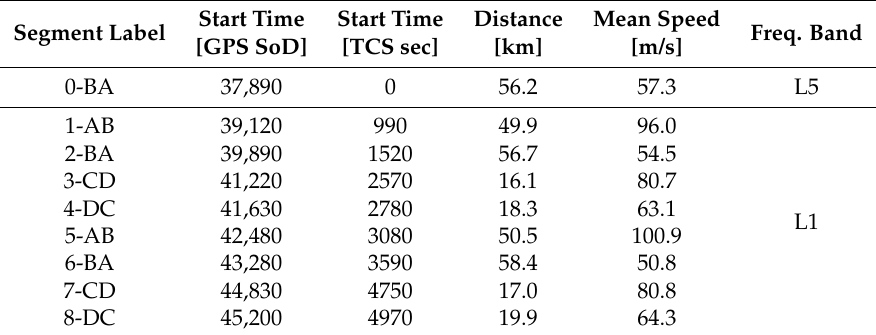
Table 1. Relevant information on the different flight segments. Two different time references are given: GPS second of the day (SoD) and time from connected segments (TCS) after removing aircraft